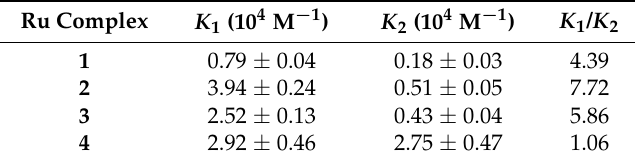
Table 1. Negatively-charged ions observed by electrospray ionization mass spectroscopy (ESI-MS) for the high performance liquid chromatography (HPLC) fractions (Figure 1) from the reaction mixtures of complexes 1 – 4 with 1 mol equiv of single-strand I . For mass spectra, see Figure S1. m / z : Observed (Calculated) Ru Complex [I] 3 − [I + {Ru} 1 ] 3 − [I + {Ru} 2 ] 3 − 1 a: 1477.22 (1477.24) b: 1556.56 (1556.58) — 2 2 a: 1477.22 (1477.24) c: 1575.25 (1575.27) f: 1672.96 (1672.95) 3 a: 1477.22 (1477.24) d: 1569.91 (1569.92) g: 1662.65 (1662.60) 4 a: 1477.22 (1477.24)